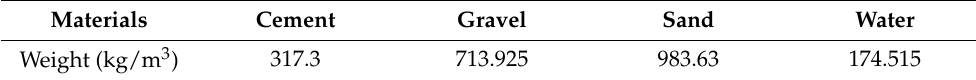
Table 3. Proportion of concrete mix design for 1 m